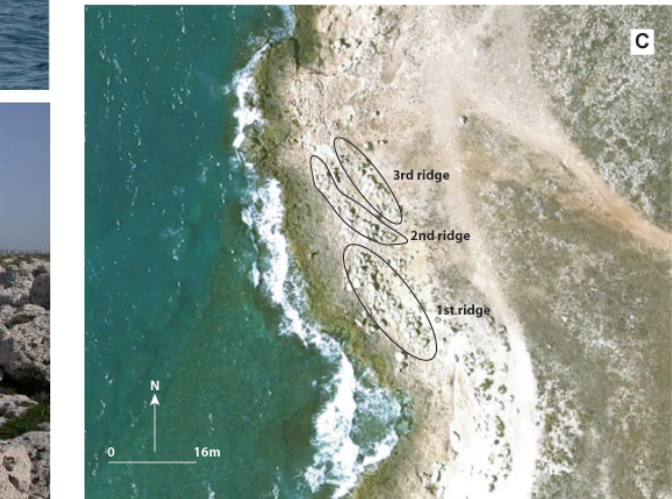
Fig. 6. Profiles on seaward side of blocks 3 and 10. (A) Clast deposits viewed from the sea and (B) clift-top clast deposits forming elongate train parallel to the coast in the upper part in the northern sector. (C) Clast accumulations in the southern sector of Arnette calanque forming three ridges parallel to the coast, which are successive in the case of ridges 2 and 3. (D) , (E) , (F) Tilted characteristic forms of littoral karst and notch after landward transport. (G) , (H) , (I) , (J) Biological encrustation on boulders. (G) Lithophaga lithophaga . (H) Balanus sp. and microperforations of boring sponge ( Cliona sp.). (I) Vermitidae. (J) Rim of Lithophyllum bisso¨ıdes